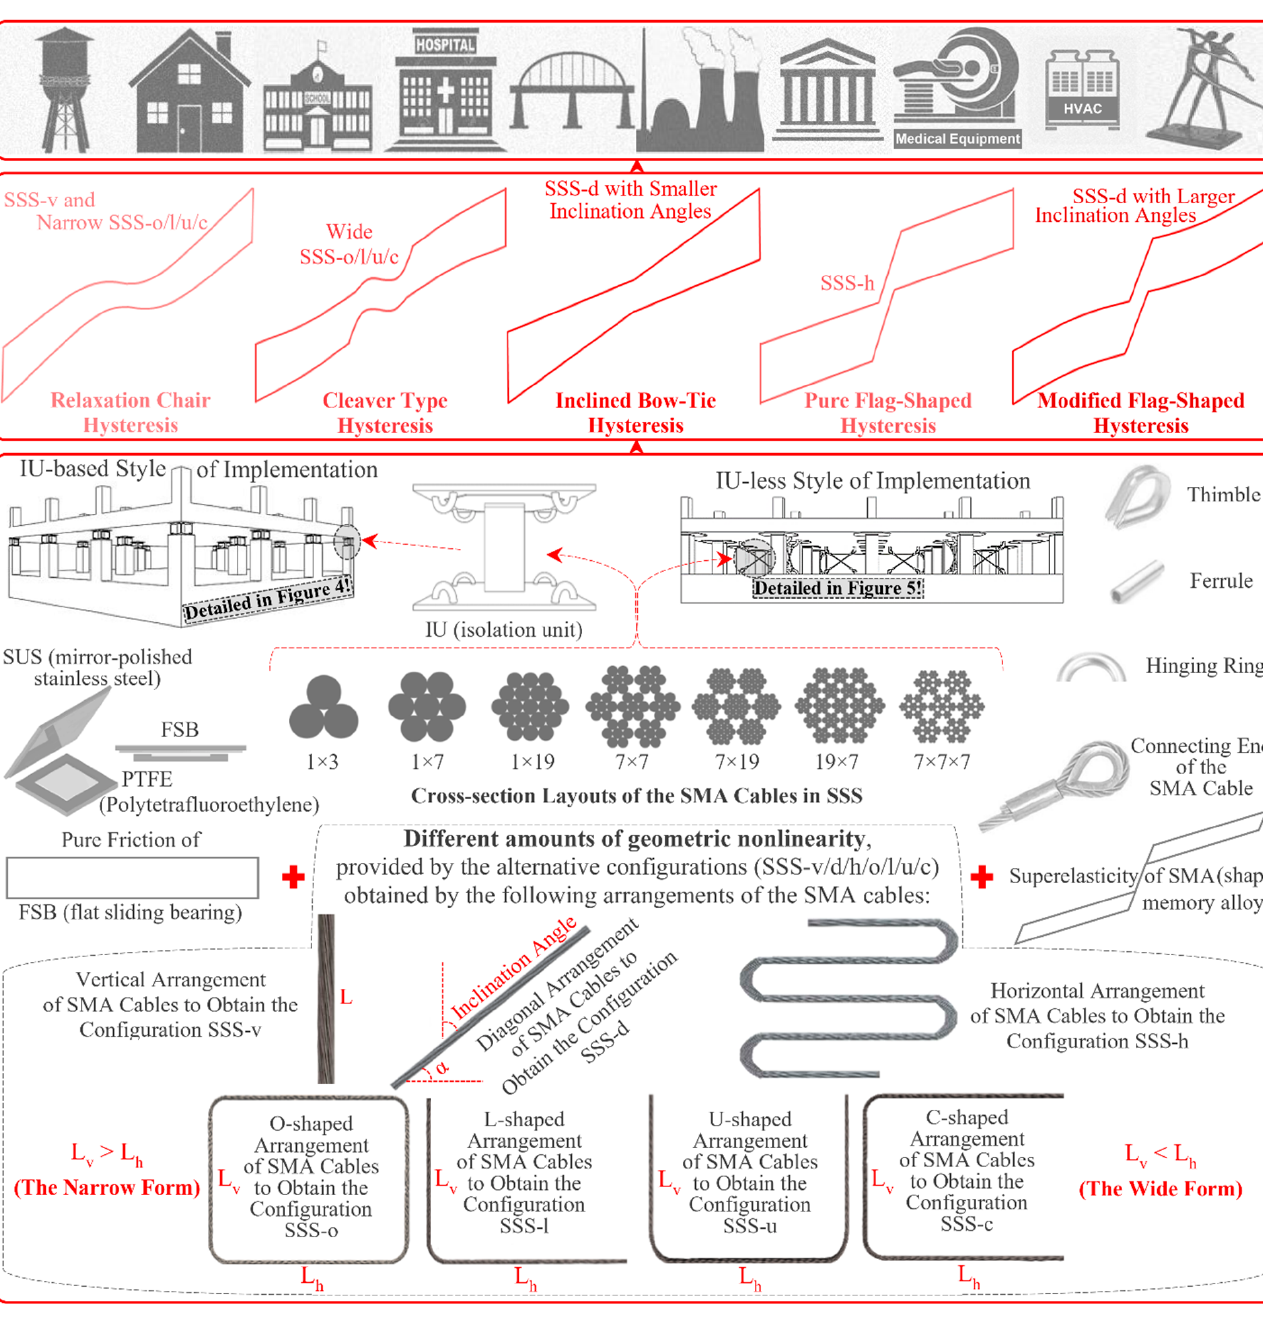
Figure 3. The versatility of SSS, at a glance.